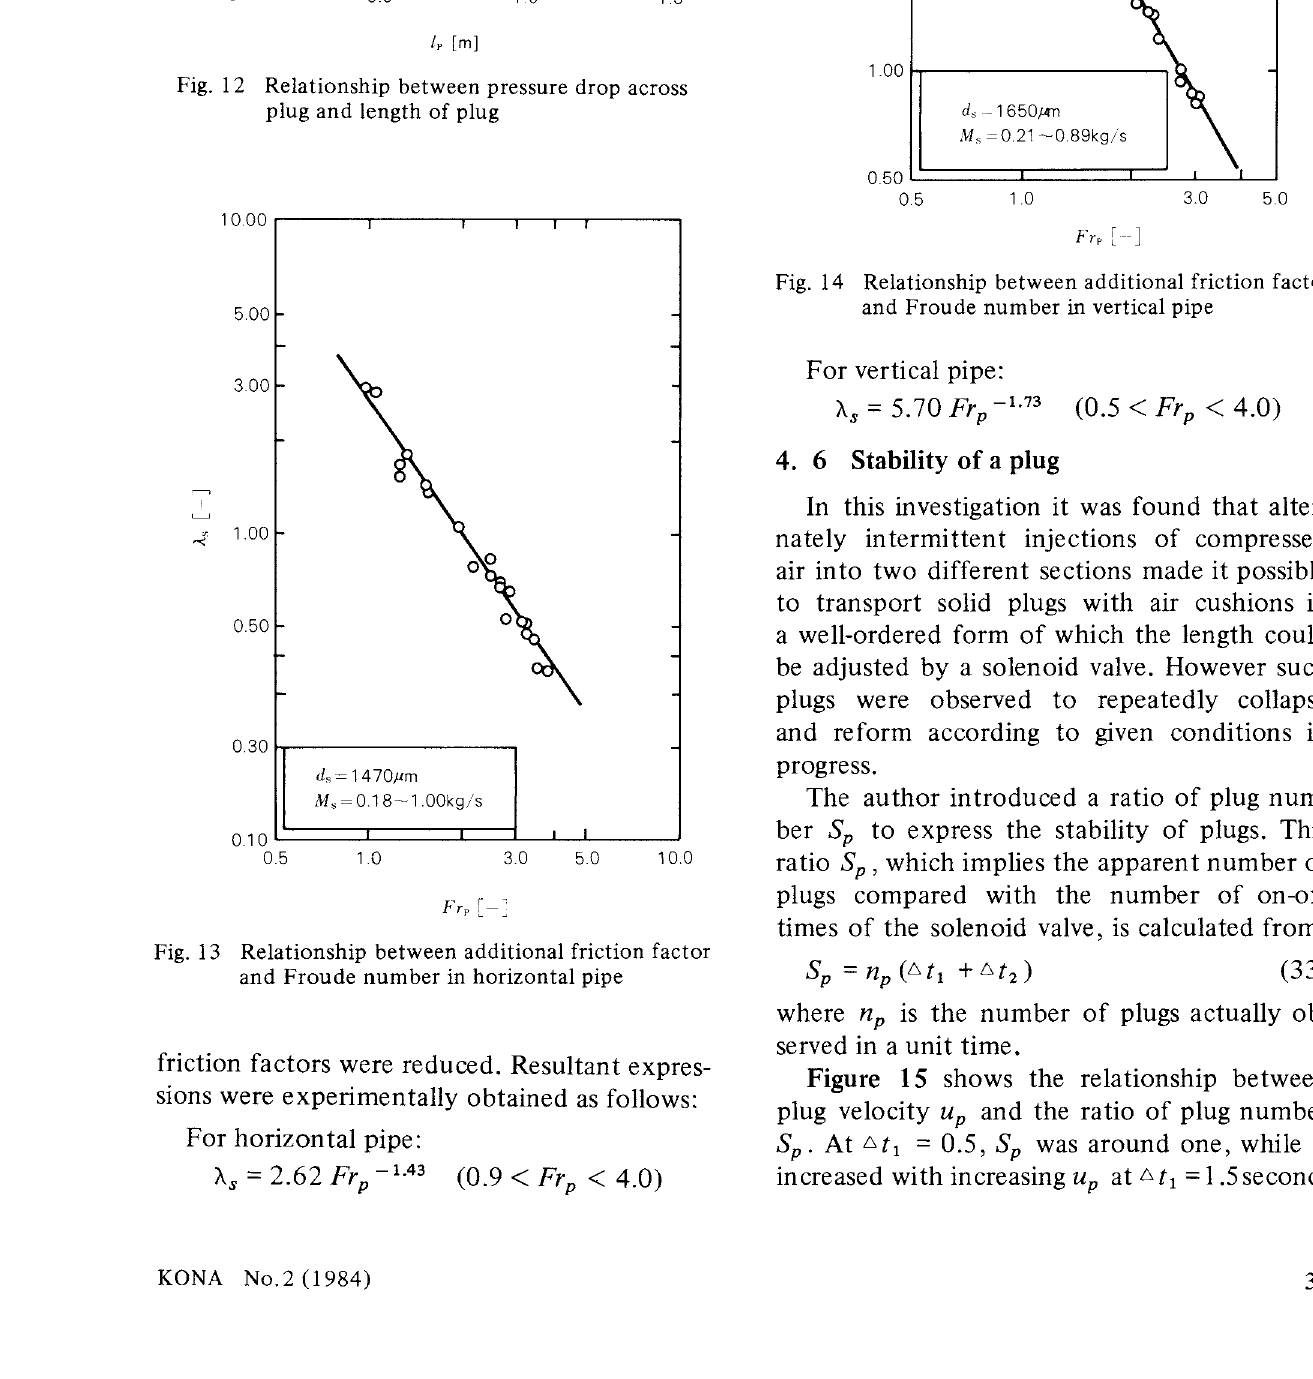
Fig. I 2 Relationship between pressure drop across plug and length of plug